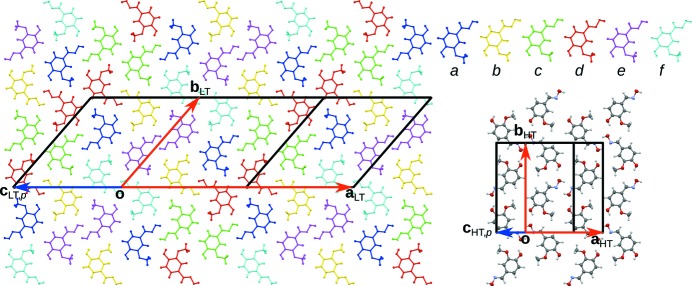
A comparison of a crystallochemical layer (left) in the LT phase and (right) in the HT phase, projected onto the (001) layer plane. The HT-phase atom colours are as in Fig. 1 ▸. The molecules in the LT phase are coloured according to space-group symmetry equivalence.